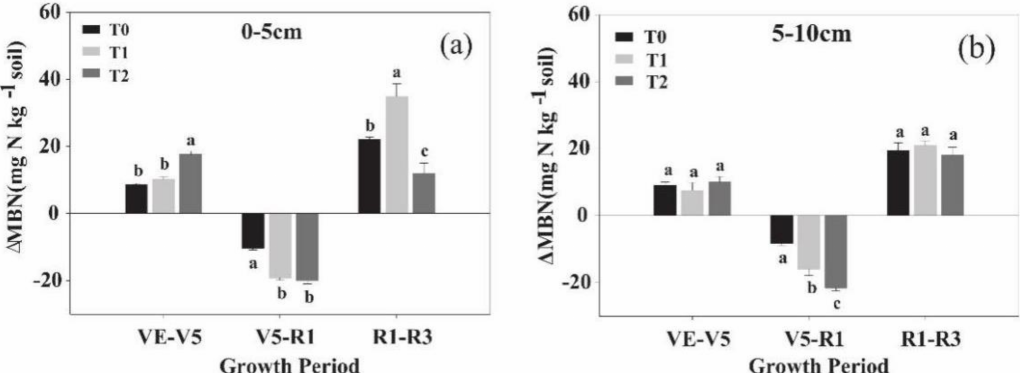
Figure 2. ∆ MBN in the three growth periods (VE − V5, V5 − R1, R1 − R3) under three different residue placement treatments (T0, none; T1, surface; and T2, incorporated) in 0–5 cm ( a ) and 5–10 cm ( b ) soil layers during maize-growing season in the pot experiment. Mean value ± standard error ( n = 4) is shown. Different letters above the bars indicate statistically significant differences at p <